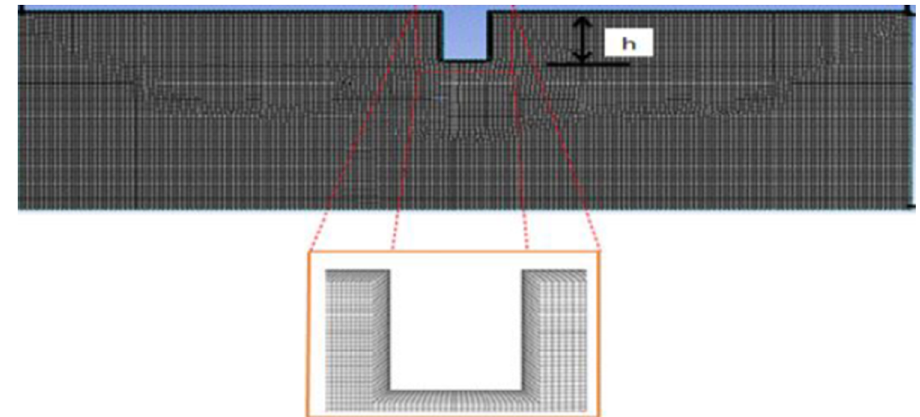
Figure 2: The simulated